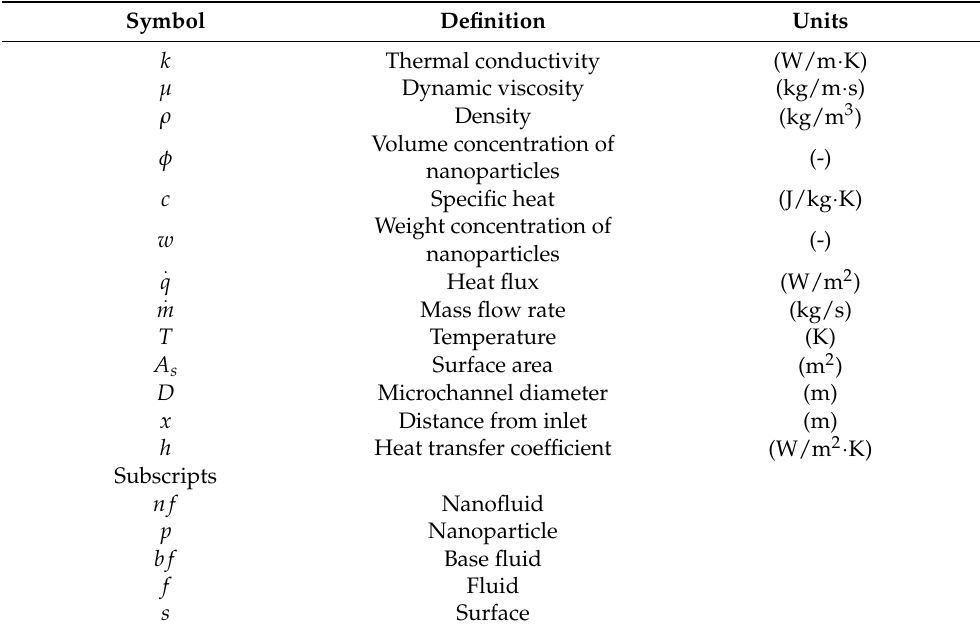
Table A1. Nomenclature with standard